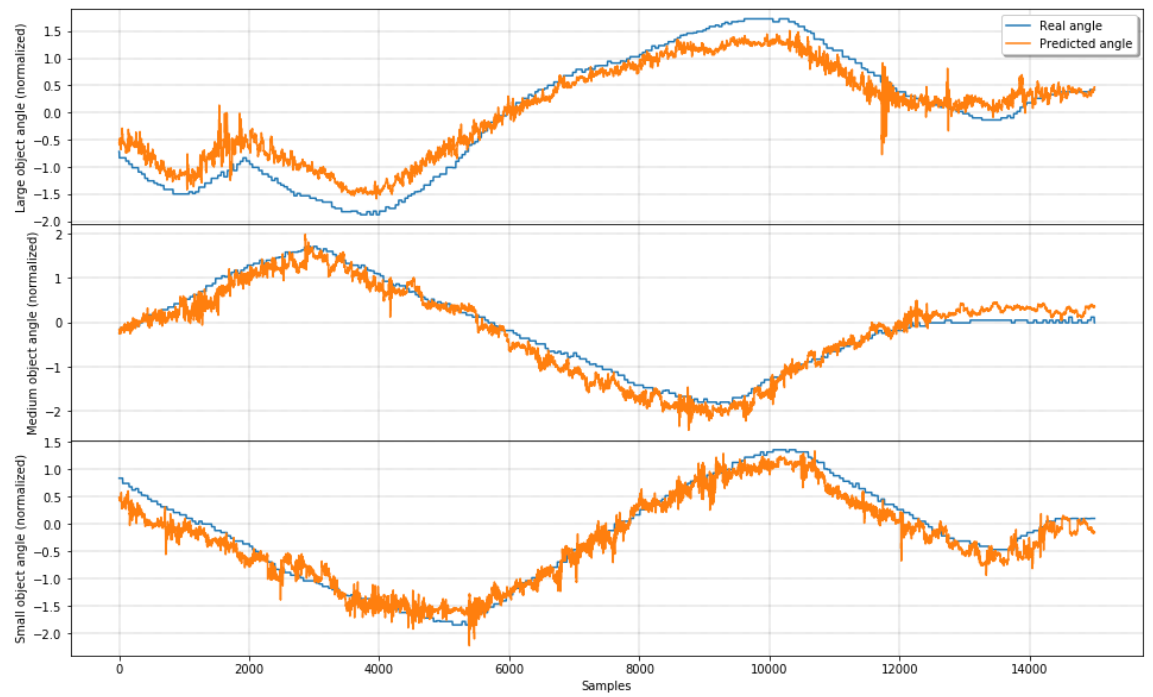
Figure 16. Angle prediction compared to real angle using ridge